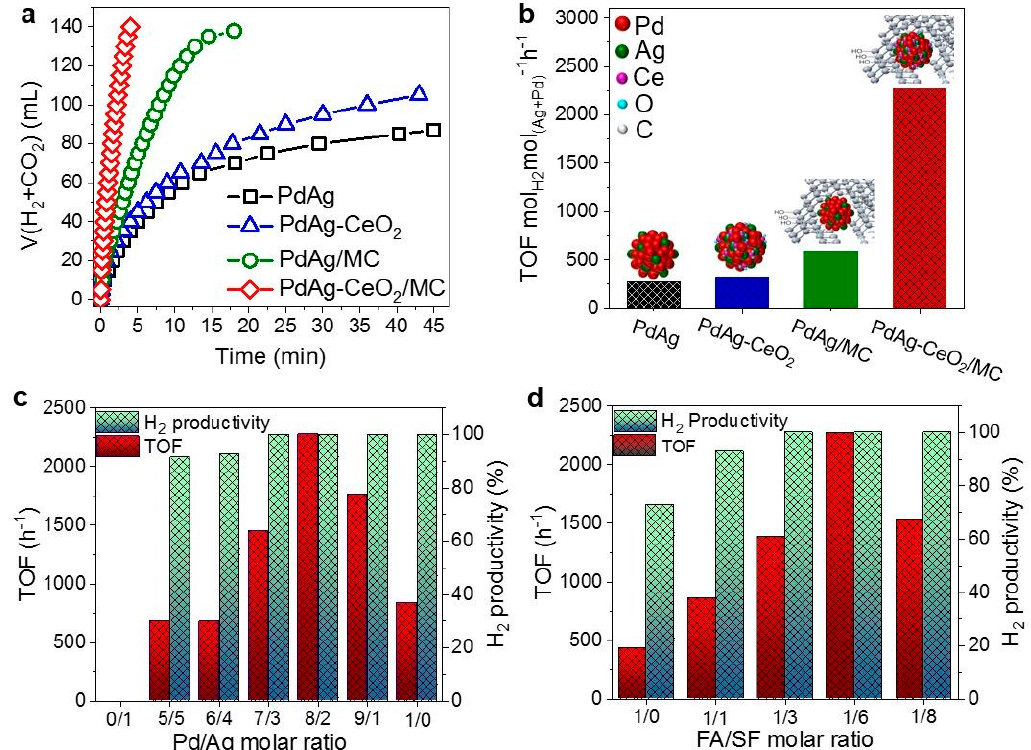
Figure 4. ( a ) Volume of the generated gas (H 2 + CO 2 ) versus time and ( b ) the corresponding TOF values for FA dehydrogenation in a FA-SF solution at 30 °C over PdAg, PdAg-CeO 2 , PdAg/MC and PdAg-CeO 2 /MC catalysts, respectively (n FA /n SF = 1/6; n (Pd+Ag) :n FA = 0.033); ( c ) Catalytic performance of the PdAg-CeO 2 /MC catalysts with different Pd/Ag molar ratios for FA dehydrogenation at 30 °C in a FA-SFs solution (n FA /n SF = 1/6; n (Pd+Ag) : n FA = 0.033); ( d ) Catalytic performance of the optimised Pd 0.8 Ag 0.2 -CeO 2 /MC catalyst for FA dehydrogenation at 30 °C in FA-SF solutions with different FA/SF molar ratios. Reprinted with permission from [72].